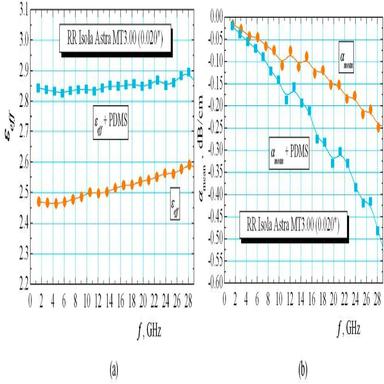
(a) Calculated effective dielectric constant and (b) attenuation of a microstrip line on substrate ISOLA Astra MT 3.0 without and with covering PDMS sample.